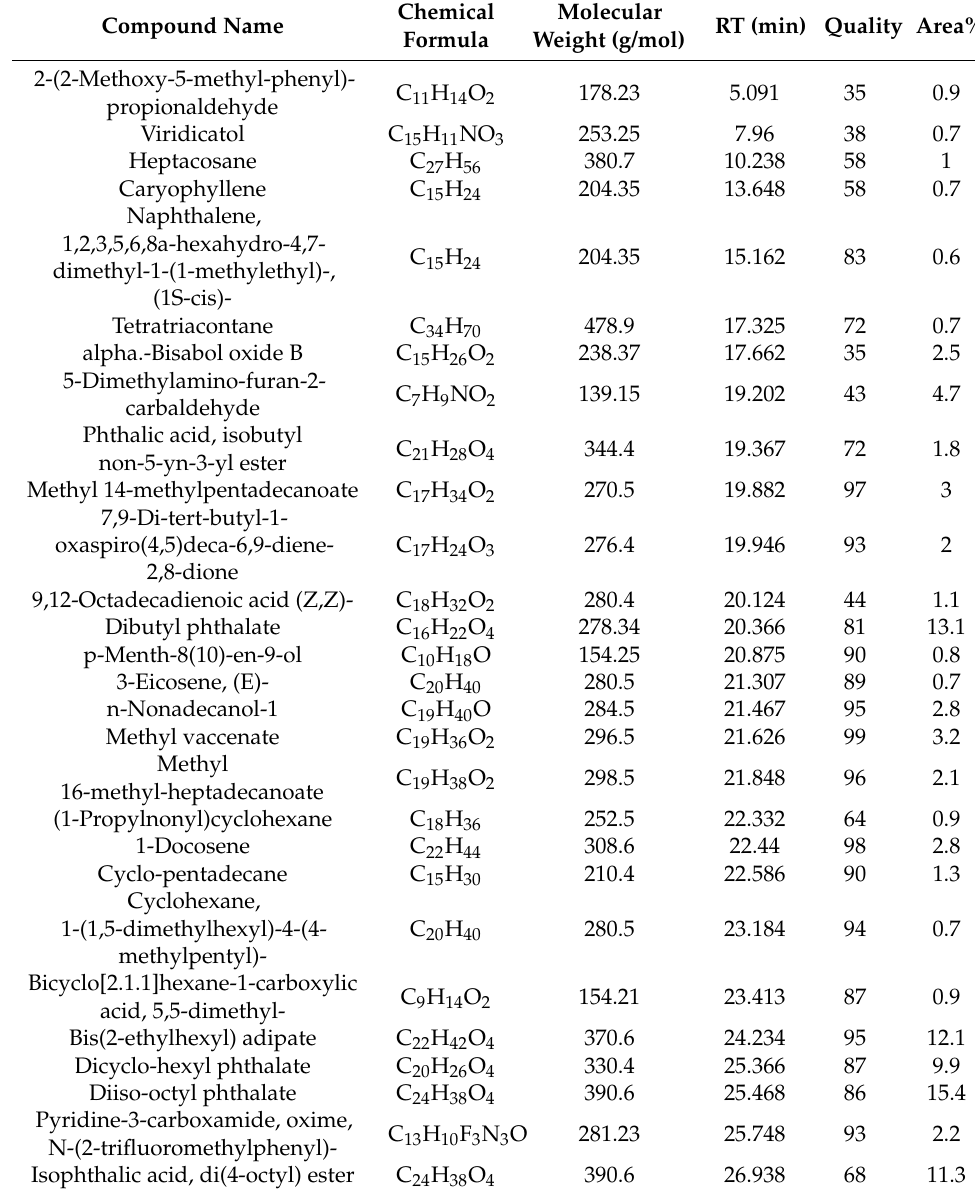
Table 6. GC-MS analysis of the crude hexane extract obtained from mycelia-free medium used in cultivation of ascospores of T . nivea